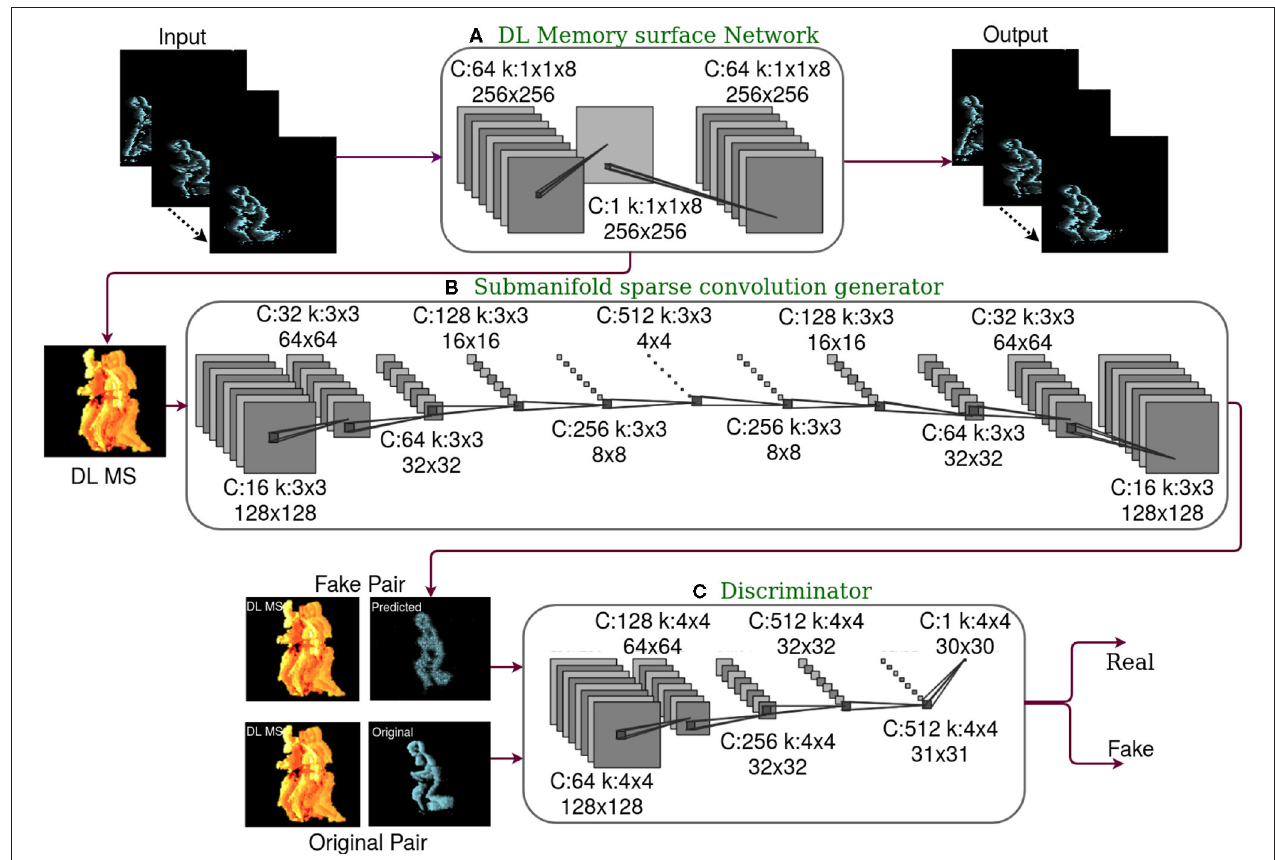
FIGURE 1 | The framework of the proposed deep learning (DL) memory surface network and sparse convolutional conditional Generative Adversarial Network (cGAN), where C is the number of channels and k is the kernel. (A) DL memory surface network with event volumes as input and output. Trained as stand-alone network in an unsupervised setting with activation regularization. Sparse DL memory surfaces are generated at the bottleneck layer. (B) The generator of cGAN is built with Submanifold Sparse Convolution (SSC) layers, which predict future Time Surfaces (TS) conditioned on DL memory surface. Only generator is used during inference. Hence building a generator with SSC layers aids in the reduction of computational complexity. (C) Discriminator of cGAN, which is exposed to real pair of images (DL memory surface and original future TS) and fake pair of images (DL memory surface and predicted future TS). This contributes to the adversarial loss of cGAN during the training